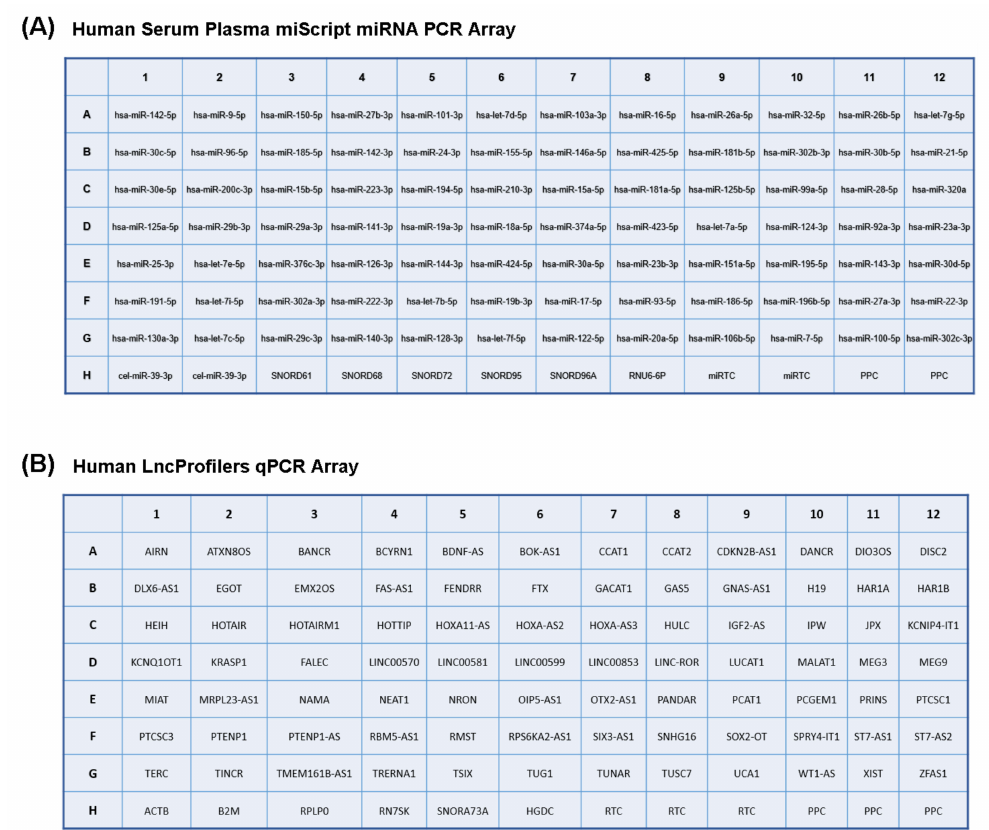
Figure 6. ( A ) plate layout for Human Serum & Plasma miScript PCR Array. Cel-miR-39-3p are spike-in controls SNORD61, SNORD68, SNORD72, SNORD95, SNORD96A, RNU6-6P; housekeeping genes miRTC are controls for retrotranscription, PPC positive controls for PCR. ( B ): Plate layout for Human LncProfilers qPCR Array. Endogenous reference RNAs for the normalization: ACTB, B2M, RPLP0, RN7SK, SNORA37A, as well as control for human genomic DNA contamination, reverse transcription controls, and positive PCR